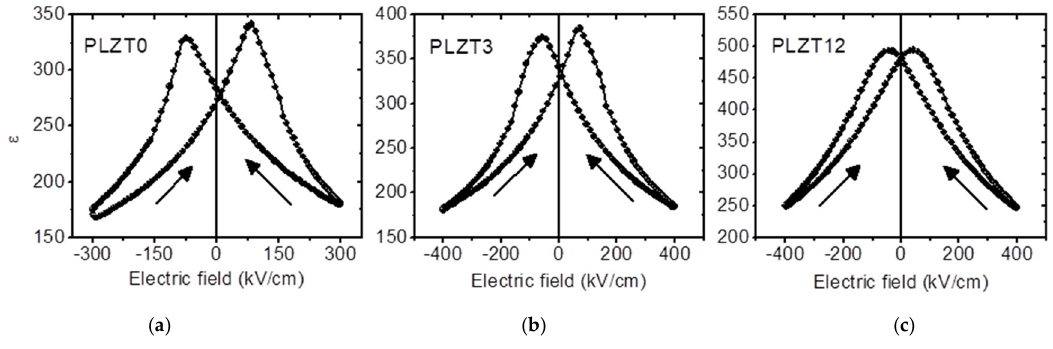
Figure 2. Dielectric permittivity–electric field ( ε -E ) curves for PLZT0 ( a ), PLZT3 ( b ) and PLZT12 ( c ) films with x = 0, 3 and 12 mol% La recorded at 100 kHz.